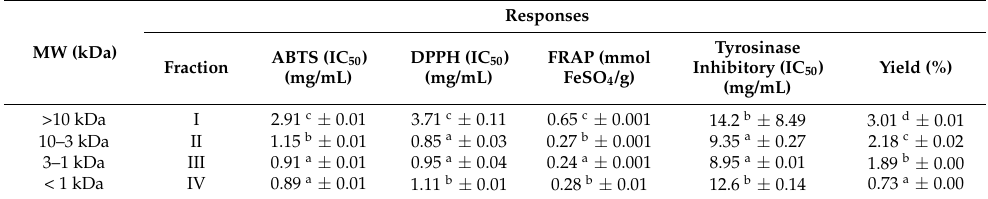
Table 5. Antioxidant and tyrosinase inhibition activity and yield from the fractionation of jellyfish hydrolysates using